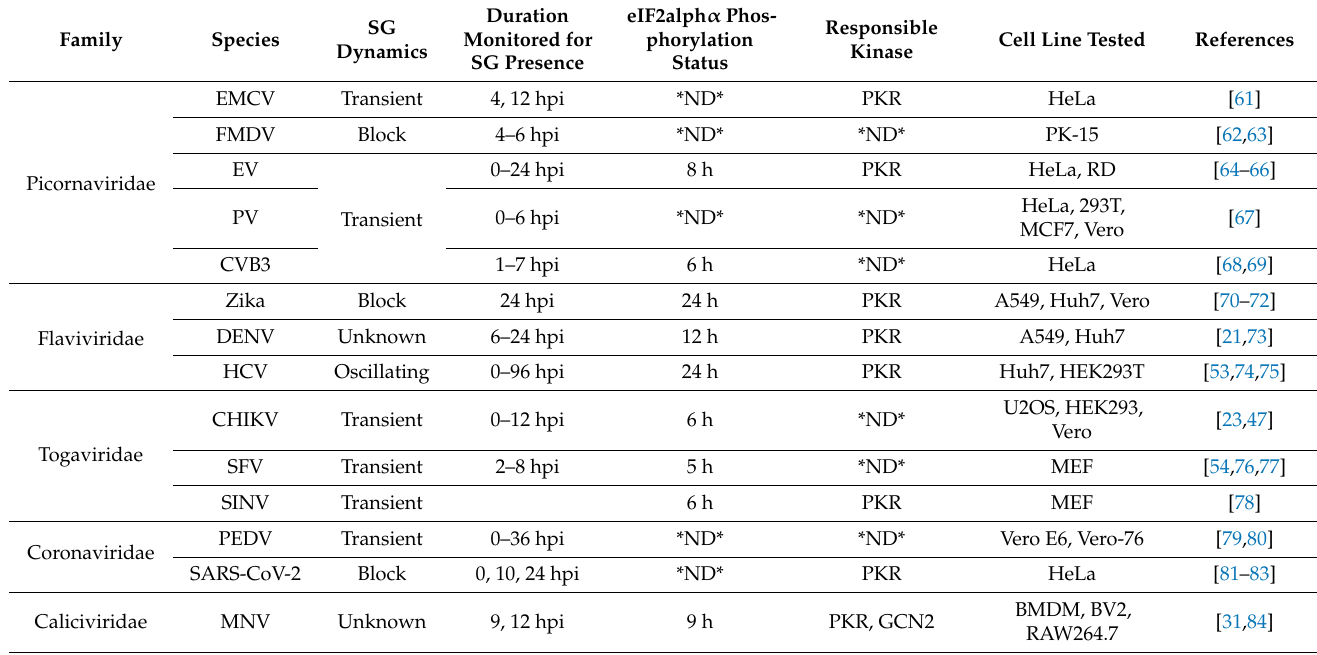
Table 1. SG status during infection against different